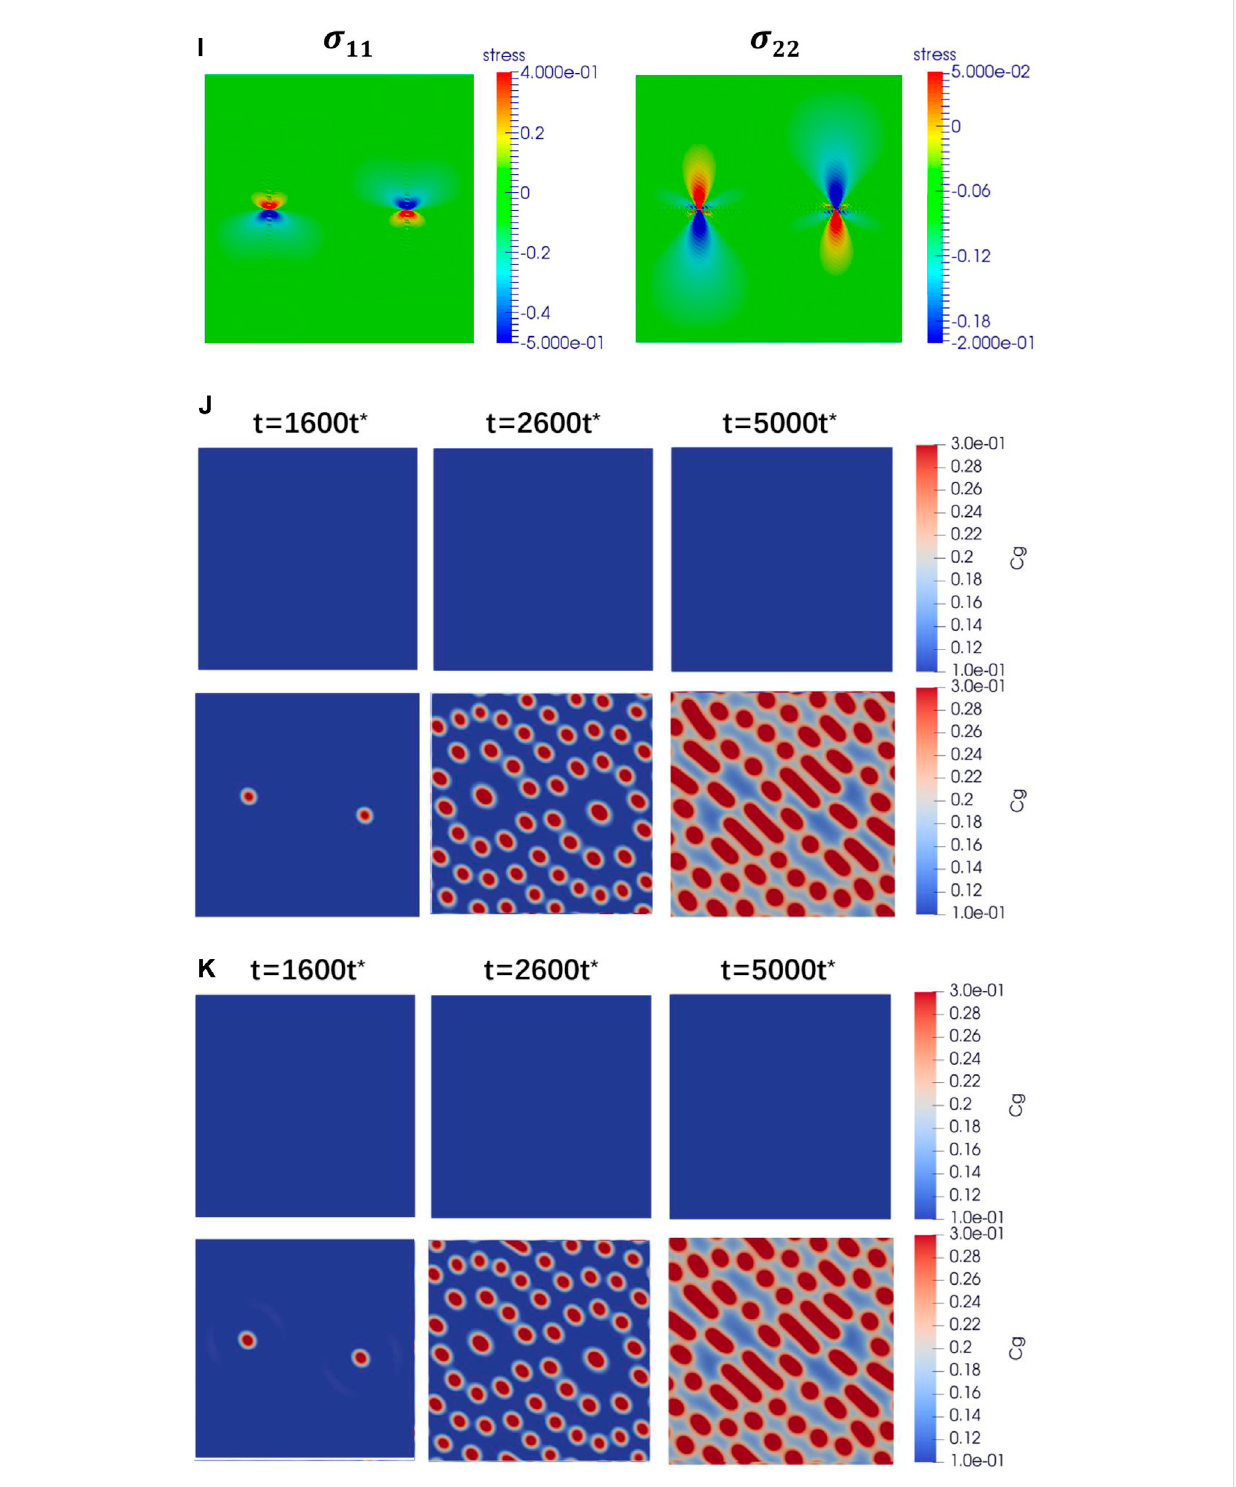
secondary Xe bubbles form at the periphery of the primary ones, arranged in dot-like layers roughly in two. With prolonged time, these bubbles coarsen in the dislocation stress at a different